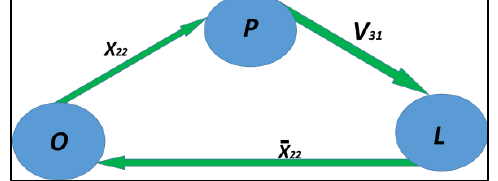
Figure 9. Automatic graph of the valve 31